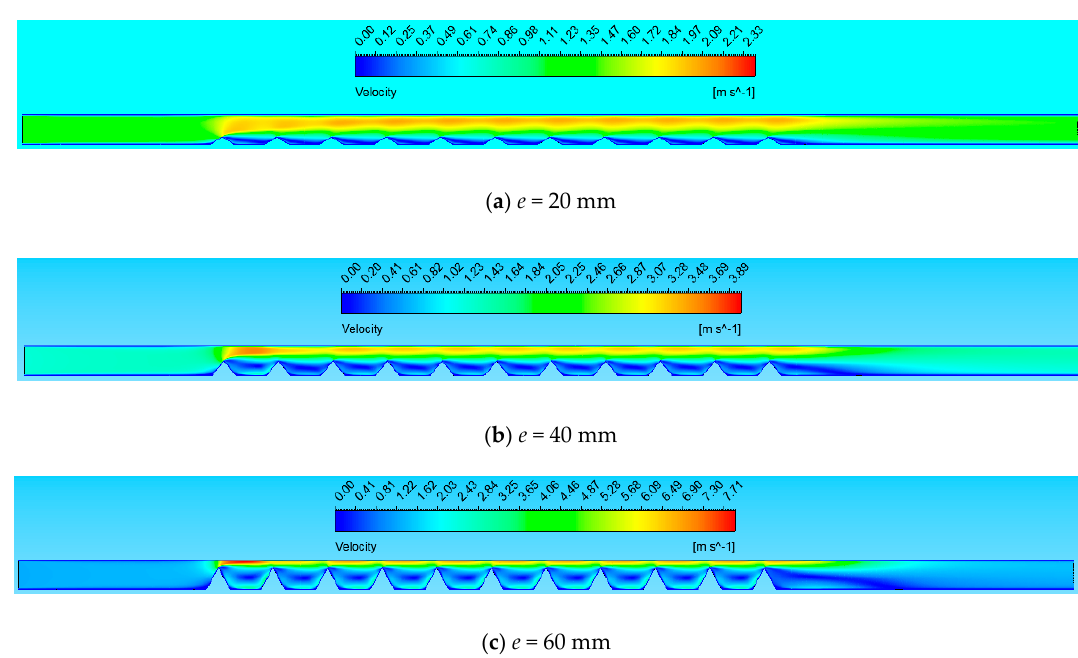
Figure 6. Velocity contours at Reynolds number of 12,000 for a fixed value of pitch ( P = 150 mm) and length ( l = 65 mm), and different value of height ( e ).